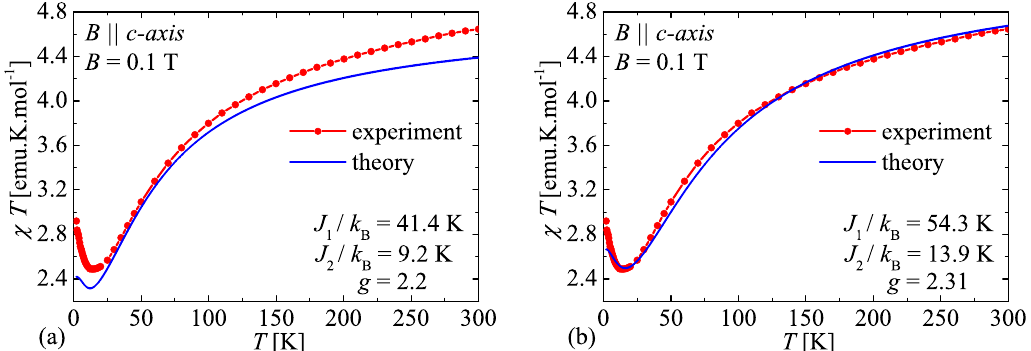
Figure 9. Temperature variations of the susceptibility times temperature product of the nickel complex {Ni 4 } (a red line with filled circles) at the magnetic field B = 0.1 T versus the respective theoretical prediction based on the spin-1 Heisenberg diamond cluster (a blue line) when considering two different sets of the fitting parameters. The fitting set specified in the panel ( a ) is taken without any further adjustment from the previously described fitting procedure of the high-field magnetization data, whereas the fitting set specified in the panel ( b ) represents the best fit of the susceptibility